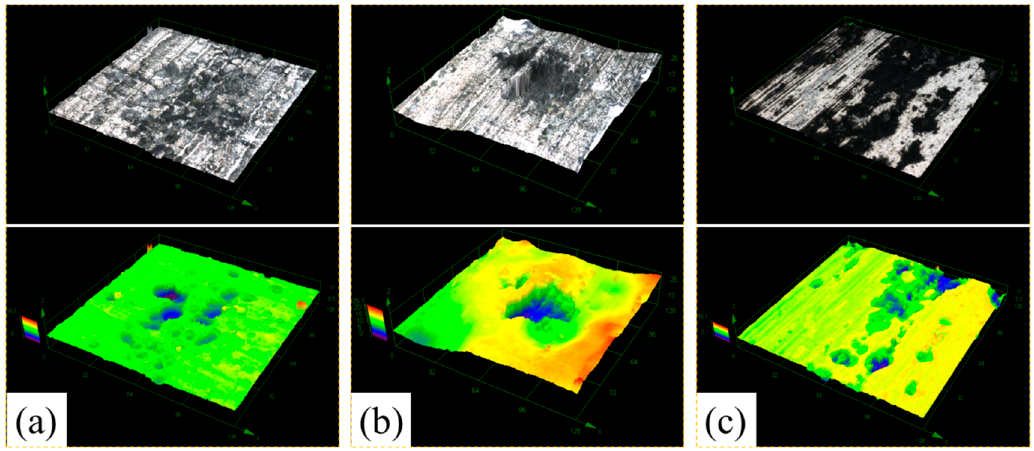
Figure 8. LSCM morphologies of 2A02 Al alloy substrate on removal of corrosion products after corrosion for 200 h ( a ) at 30 °C; ( b ) at 60 °C; and ( c ) at 80 °C.